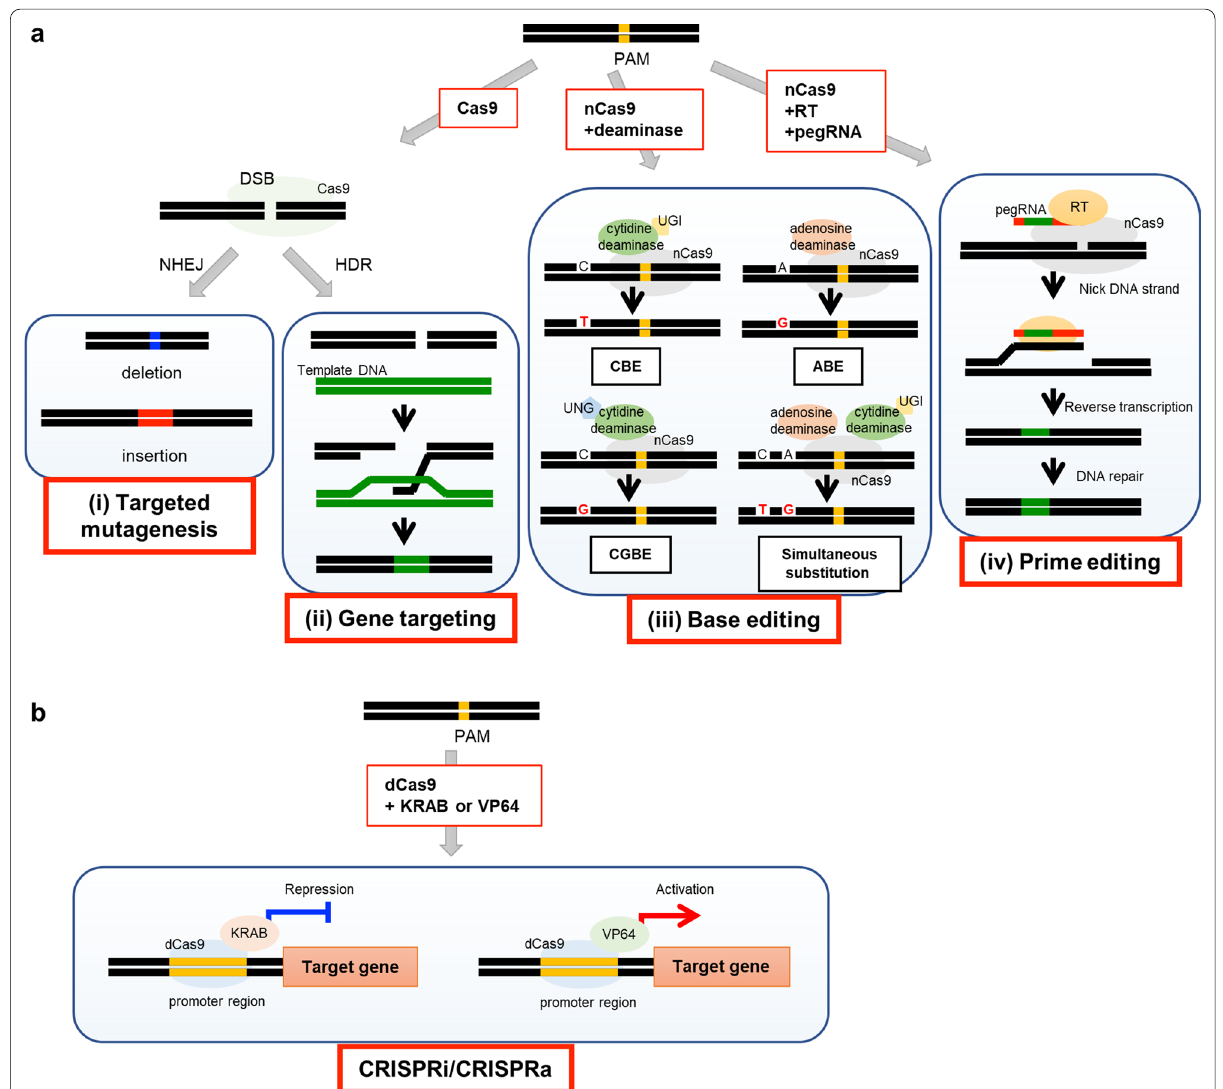
Fig. 1 Summary of latest genome editing technologies. a Genome editing technologies involved in modification of DNA sequences. (i) Cas9 delivered to the target sequence by gRNA causes targeted mutagenesis. (ii) If template DNA is present, GT occurs, but infrequently. (iii) Base substitution can be introduced into a target sequence by a base editor. (iv) By combining nCas9 with pegRNA and RT, the target sequence can be inserted accurately into the target site: “prime editing”. b Genome editing without modification of DNA sequence. CRISPRi/CRISPRa can regulate gene expression of a target gene using dCas9 and a transcription factor such as KRAB or VP64. See main text for details of each